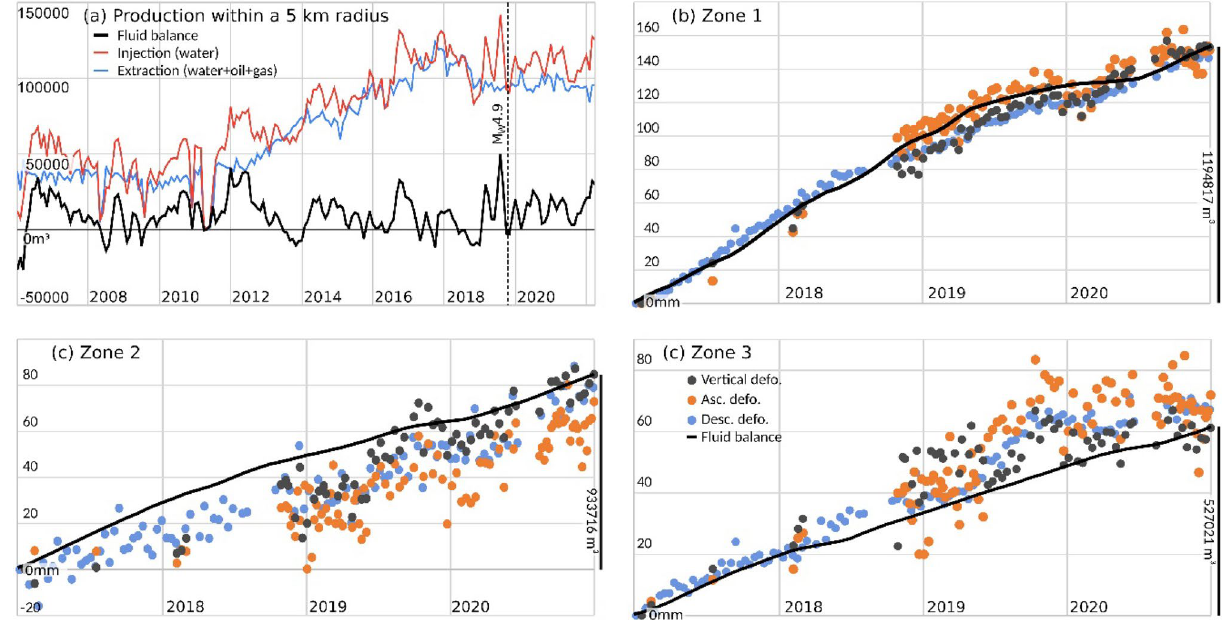
17 earthquake epicentre (red star in Fig. 6) in the GSJ basin. Fluid (water and hydrocarbons) extraction (blue) and injection (water, red) and balance between them (injection minus extraction, black). The date of the occurrence of the earthquake is indicated by a vertical line in the chronological axis. The earthquake occurs immediately after the highest injection historic peak and in the strongest and sudden historical imbalance. ( b – d ) Plots of time-series of deformation (orange for ascending orbit, blue for descending orbit) and standardised fluid balance (black line) for wells over the deformation zones labelled 1,2,3 in Fig. 6a. ( b ) Represents the trends of 85 recovery wells inside deformation zone 1, ( c ) 29 wells in zone 2, and ( d ) 15 wells in zone 3. Besides the standardisation, the scale bar in the right vertical axis provides the magnitude of the accumulated fluid balance during the analised period for the whole deformation